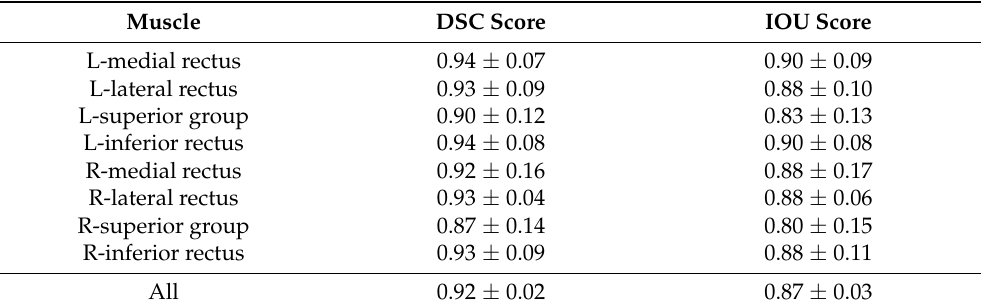
Table 3. Performance of selected U-net model (trained using WCE+Dice loss) on test data. Values indicate mean ± standard deviation of Dice score and IOU score across 32 test scans.